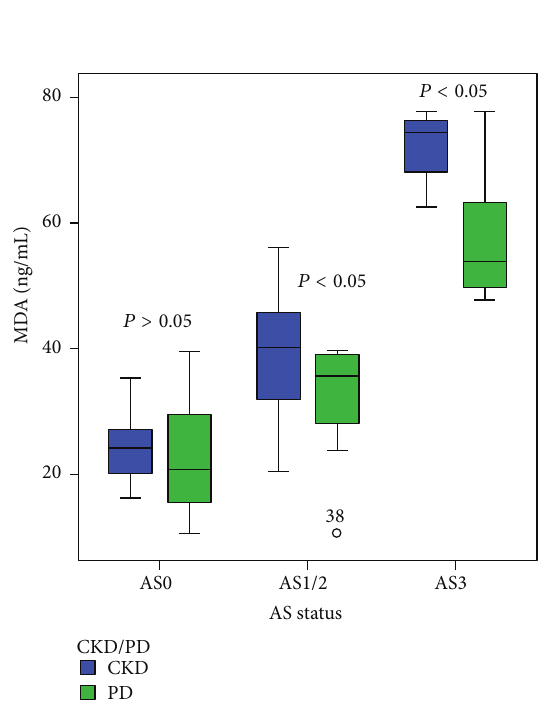
Figure 1: The relationship between serum concentrations of MDA in CKD nondialysis-dependent patients and PD patients according to the stage of atherosclerotic changes in the carotid arteries. Data are presented as median with interquartile range. Bars show the maximum and minimum value, while the square and its central bar show median and interquartile range. Note: AS: